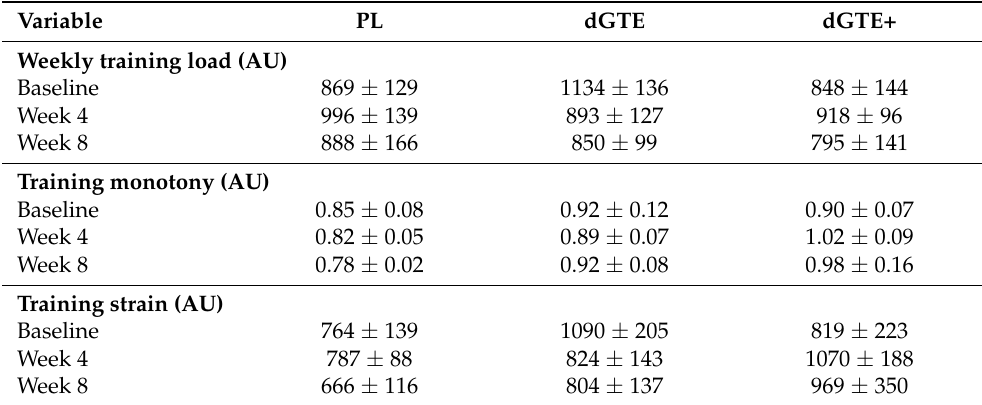
Table 3. Estimated mean training load, monotony and strain between intervention groups prior to and across the experimental